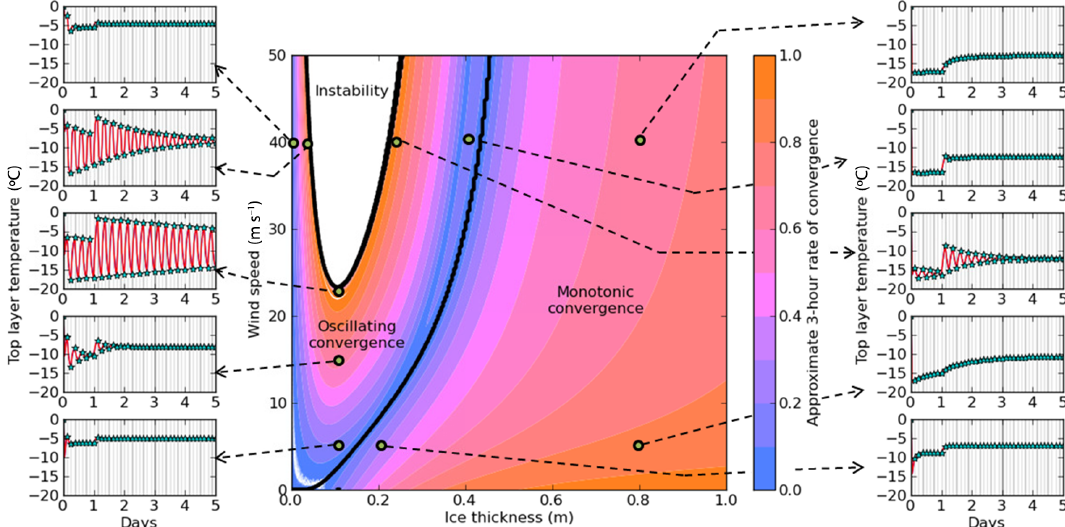
Figure A2. Map of stability of the coupled ice and surface solvers, as ice thickness and wind speed are varied, with a 3h coupling period. Speed of convergence is indicated in colour, where blue is rapid convergence, red is slow convergence. Regions of 3h monotonic convergence, 3h oscillating convergence and instability are indicated. Time series of top layer ice temperature are shown for 10 representative points of the variable space.